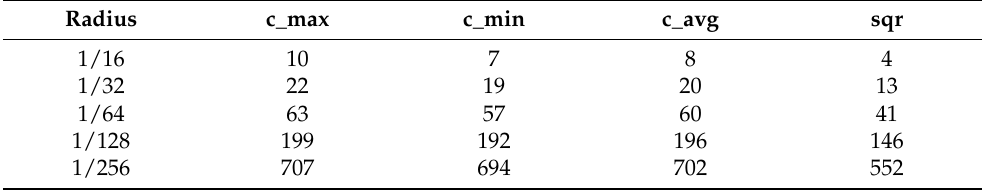
Table 4. The number of